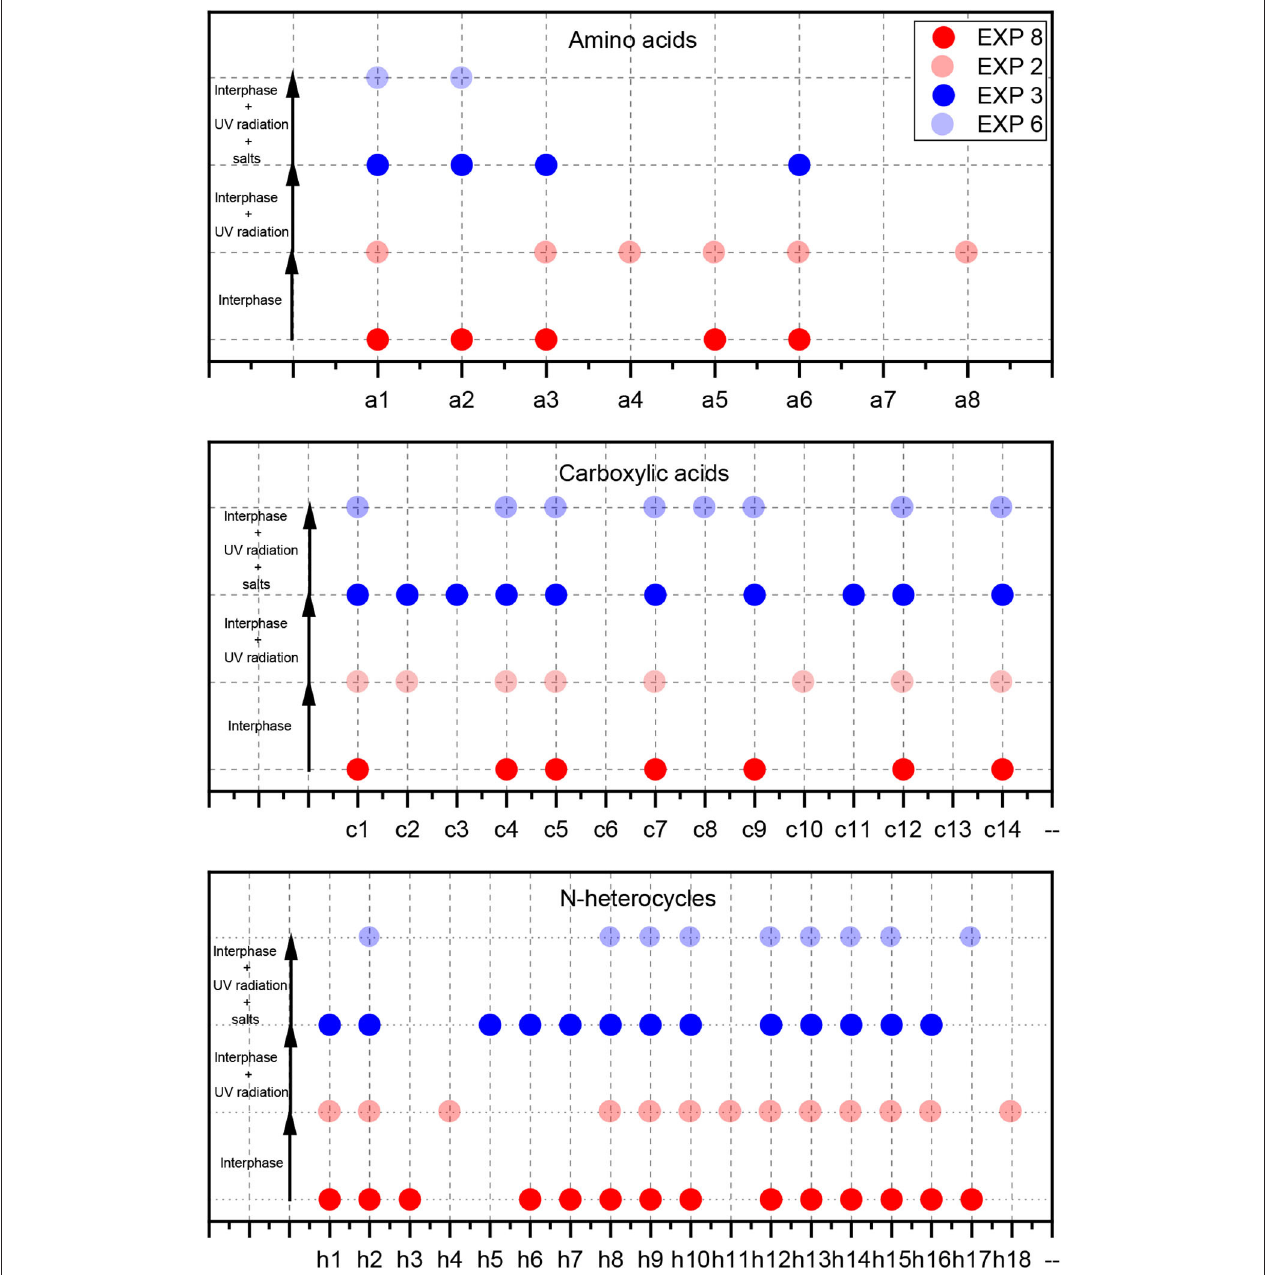
FIGURE 7 | Comparison of the experimental conditions against analytes found by GC-MS for the particular case of the experiments performed in the presence of water-ice interfaces. Note that in each step, a new variable is added. The analytes represented correspond to those identified in both the insoluble and soluble